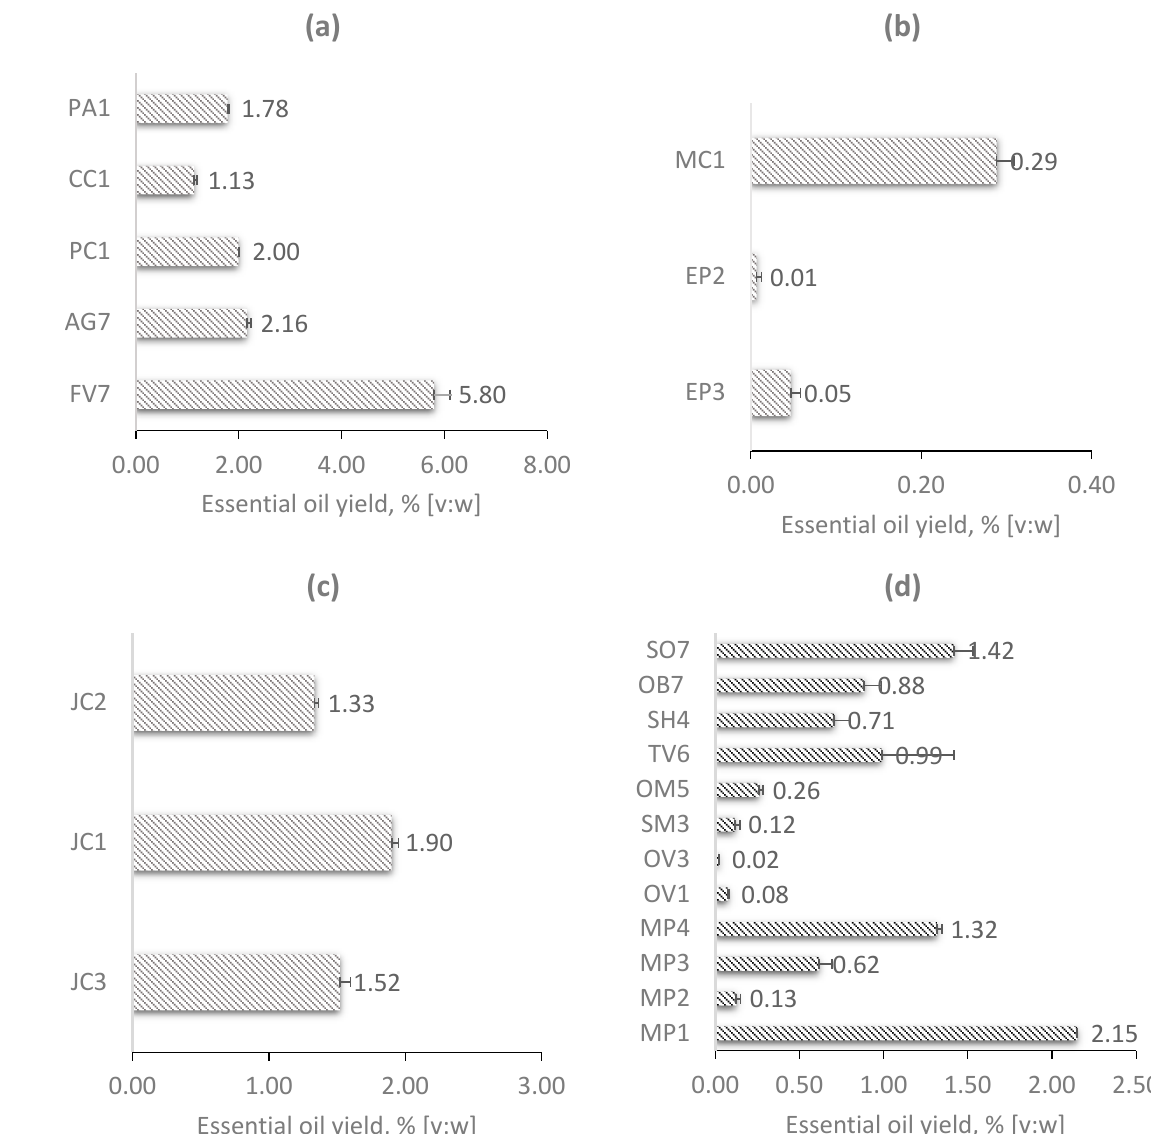
Figure 1. EOs’ yield: ( a ) Apiaceae species, ( b ) Asteraceae species, ( c ) Cupressaceae species, ( d )